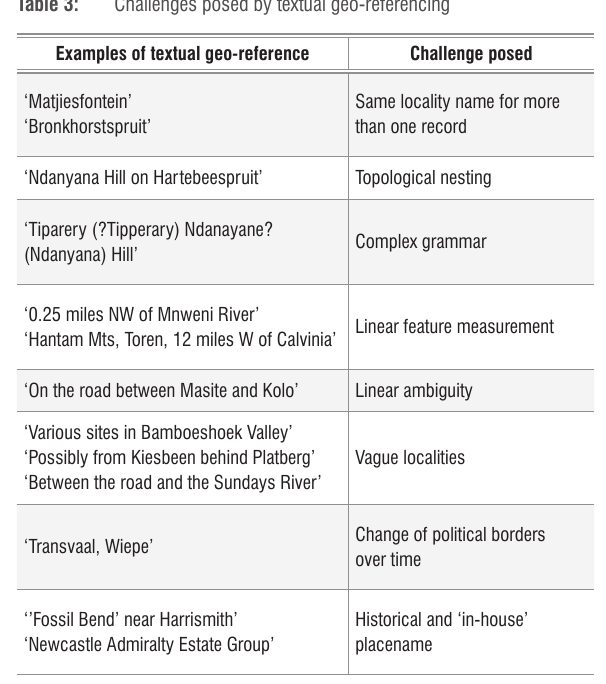
Challenges posed by textual geo-referencing